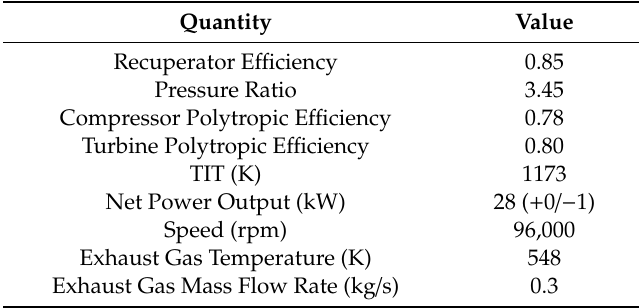
Table 1. C30 micro gas turbine datasheet, [1,3,4,7,9,10].